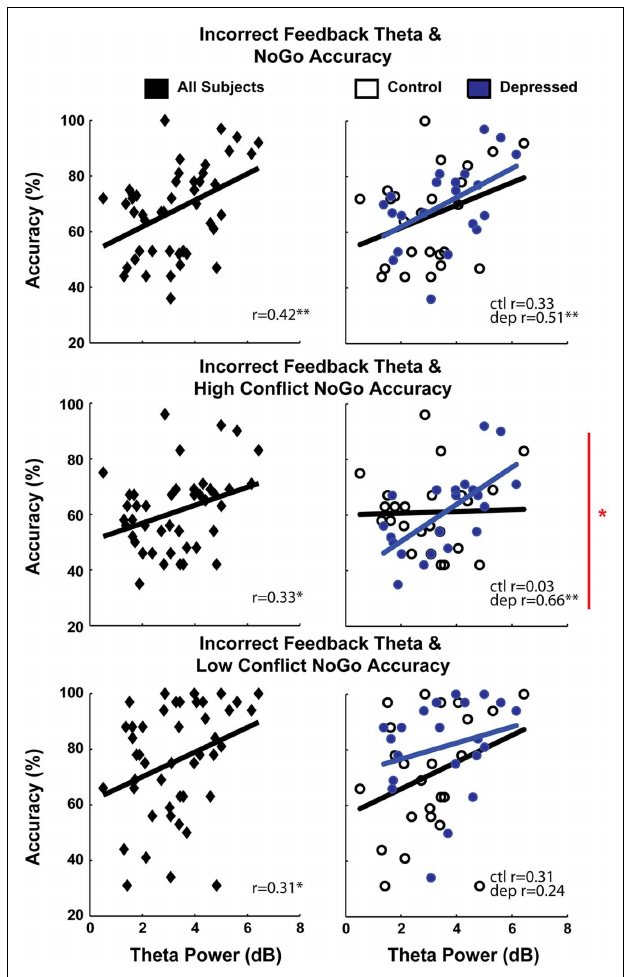
FIGURE 3 | Scatterplots demonstrating error signal–avoidance learning relationships, along with correlation test results. The first row shows total NoGo accuracy, which can be split into high and low conflict cases (rows 2 and 3). Only in the high conflict “lose–lose” cases did controls and depressed participants significantly differ from each other, demonstrating the specificity of increased error signal–avoidance learning acuity among those with